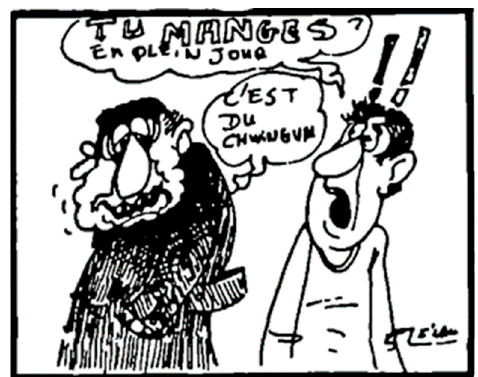
Figure 7. © unknown.